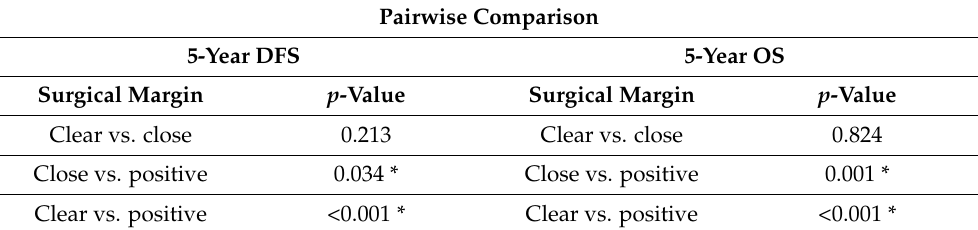
Table 2. Effect of surgical margin status on survival and recurrence after surgery to treat oral and oropharyngeal cancers ( n = 418). Pairwise Comparison